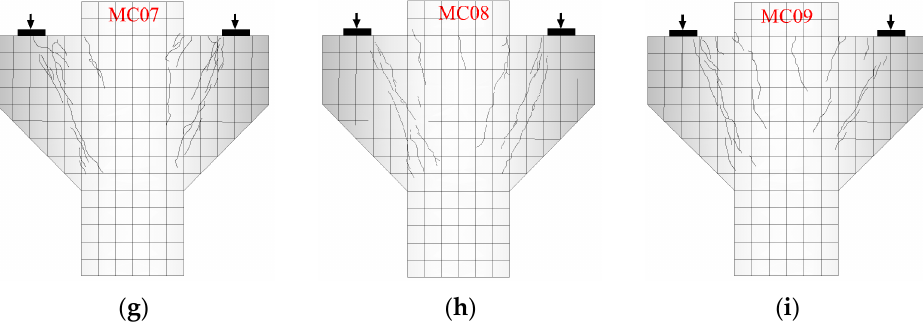
Figure 6. The crack failure of the specimens. ( a ) MC01; ( b ) MC02; ( c ) MC03; ( d ) MC04; ( e ) MC05; ( f ) MC06; ( g ) MC07; ( h ) MC08; ( i ) MC09.